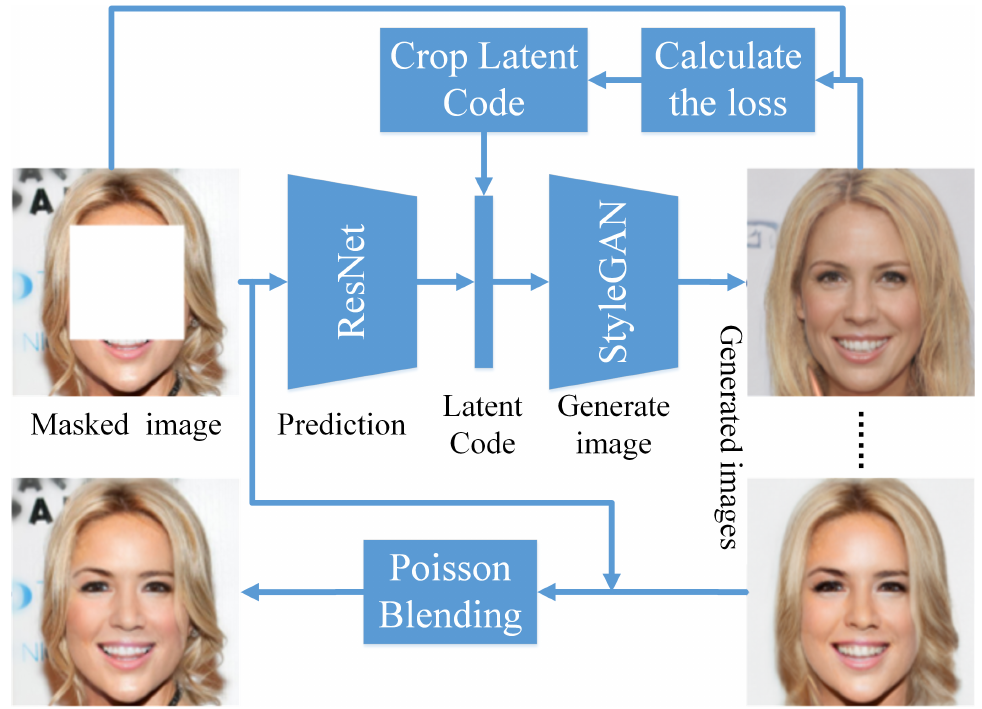
Figure 2. Network structure diagram of our